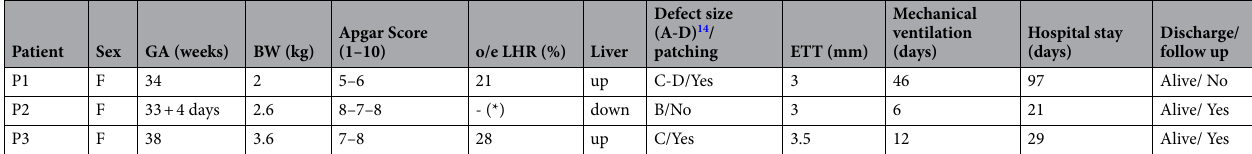
Patient Sex GA (weeks) BW (kg)